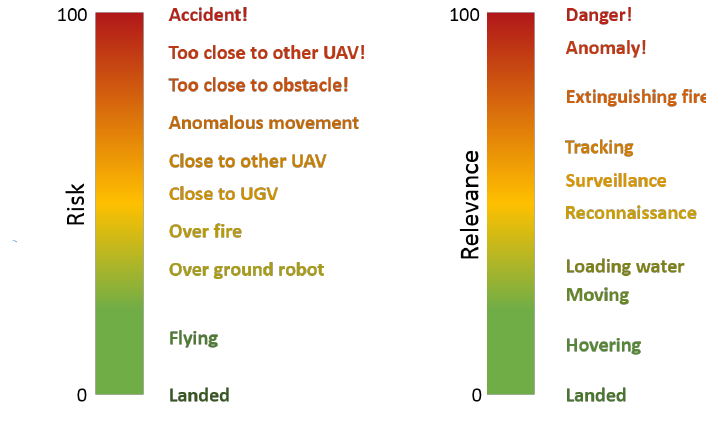
Figure 3. Approximation of evaluation criteria of operator for robot relevance and